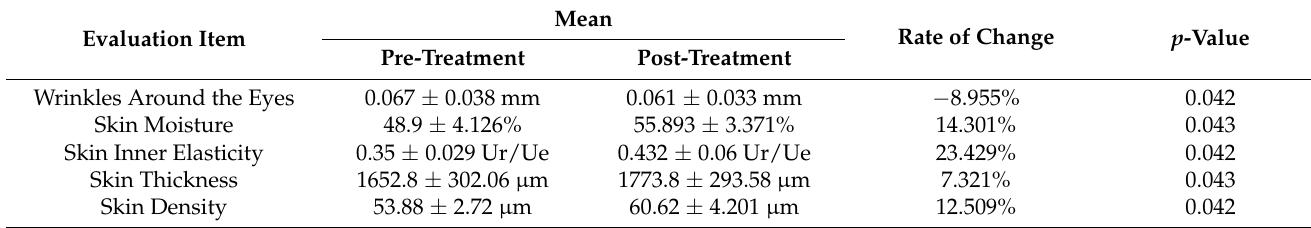
Table 3. Comparison of each evaluation item results pre and